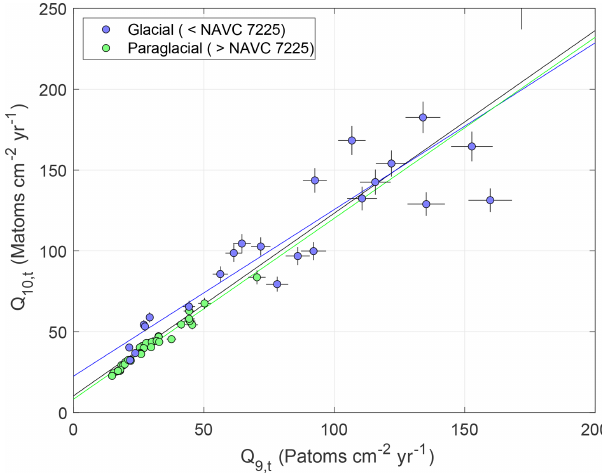
Figure 20. Regression of 9 Be and 10 Be total fluxes for glacial and paraglacial varves at